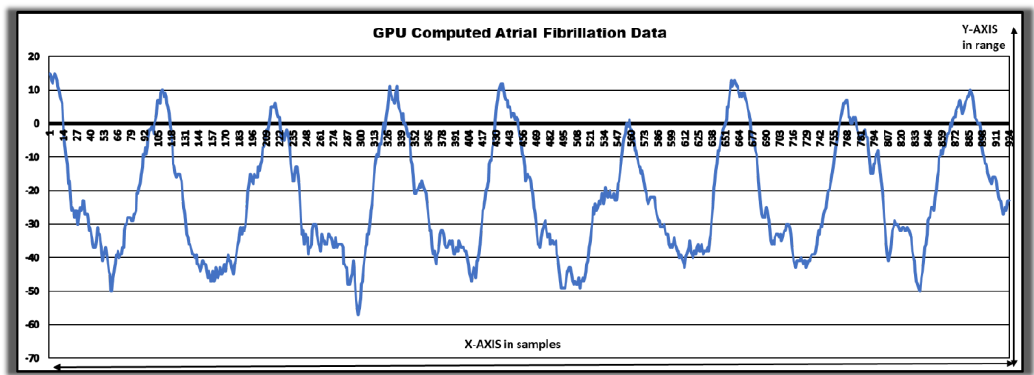
Figure 15. GPU-Computed Atrial Fibrillation Data.